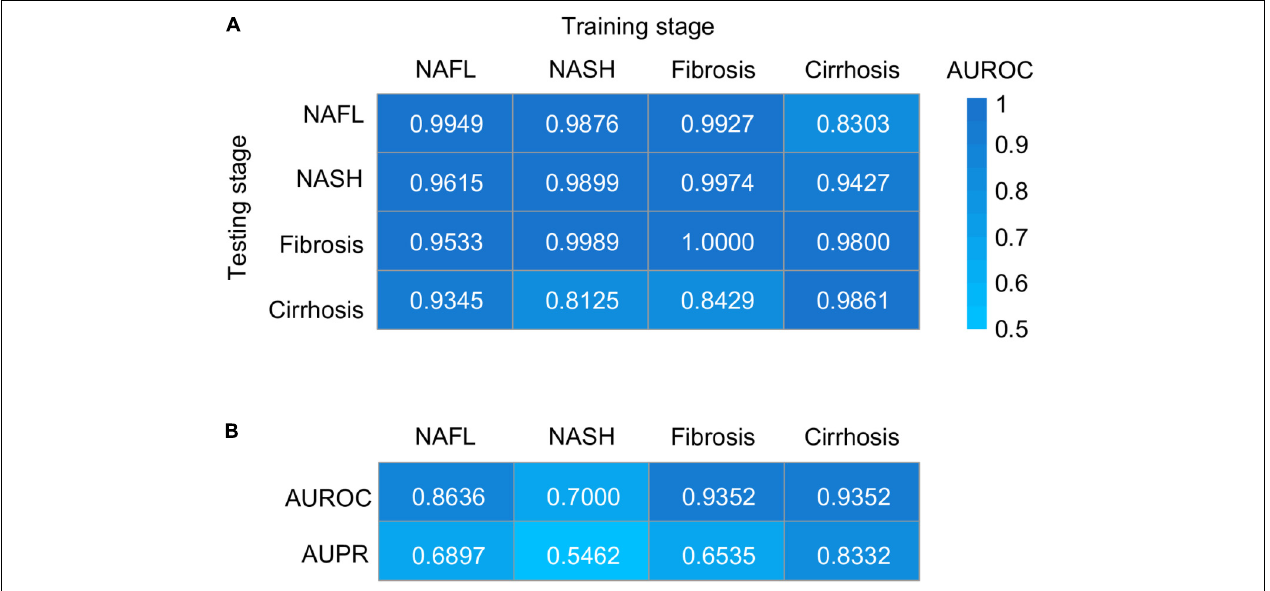
FIGURE 5 | Taxonomic classification models generalize across stages by GBM. (A) Classification accuracy resulting from validation within each stage (along the diagonal) and stage-to-stage model transfer (external validations off-diagonal) as measured by AUROC. (B) Classification accuracy resulting from the models designed to distinguish patients with one stage of NAFLD from other stages. AUROC, area under the receiver operating characteristic curve; AUPR, area under the precision–recall curve; NAFL, non-alcoholic fatty liver; NASH, non-alcoholic